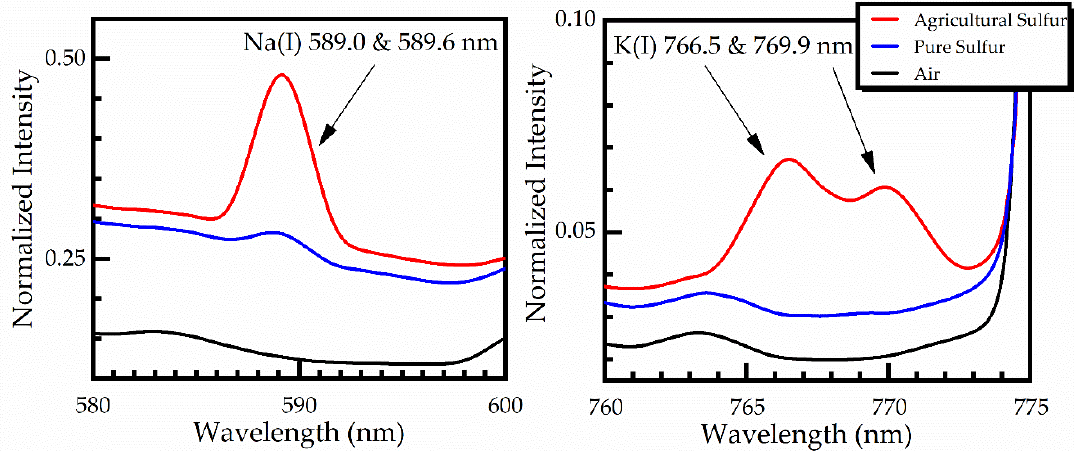
Figure 4. Sodium (Na) and Potassium (K) emission lines observed in the agricultural sulfur samples. Similarly, in Figure 5, the LIBS spectra of pure and agricultural sulfur samples, together with the LIBS spectrum of air, in the NIR region between 900 and 950 nm are presented. In this spectral region, three spectral lines of sulfur are expected to appear, namely at 921.3 nm, 922.8 nm and 923.8 nm. However, due to the limited resolution of the spectro- graph, the broadening of the lines, and their partial overlapping with the neighboring oxygen O(I) emission at 926.6 nm, they are not clearly observed. So, it was concluded that these NIR spectral lines of sulfur cannot be employed for quantitative